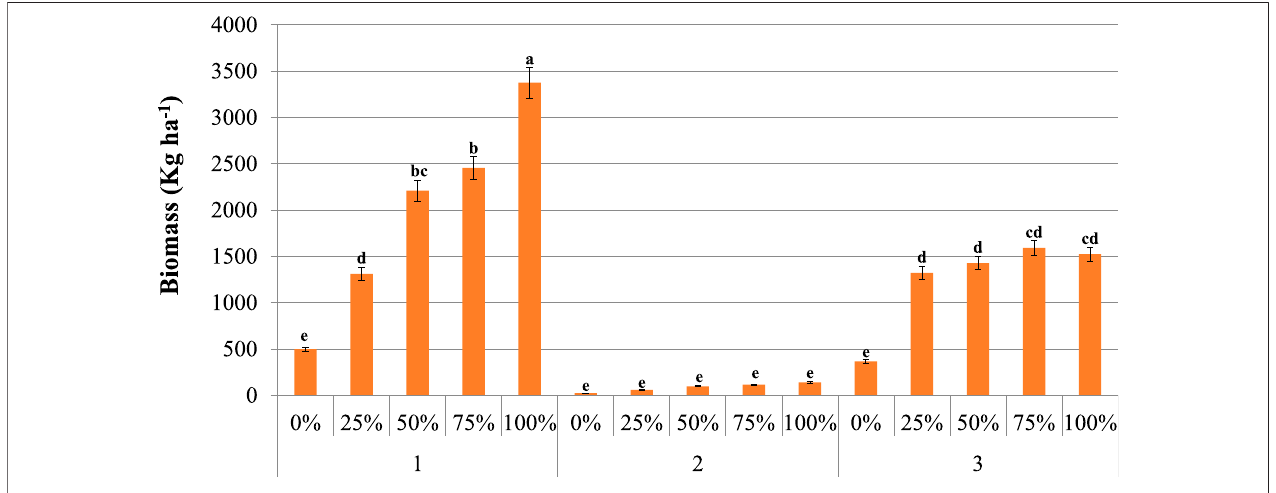
FIGURE5| ThecombinedeffectsofseasonandthinningongrassbiomassinthesavannaofsouthernEthiopia. % (cid:2) treatmentplot. # 1 (cid:2) Season1, # 2 (cid:2) Season2, and # 3 (cid:2) Season 3. Signi fi cant differences between plots based on Tukey HSD pairwise tests are indicated by different letters. Vertical bars denote a 0.95 con fi dence interval.